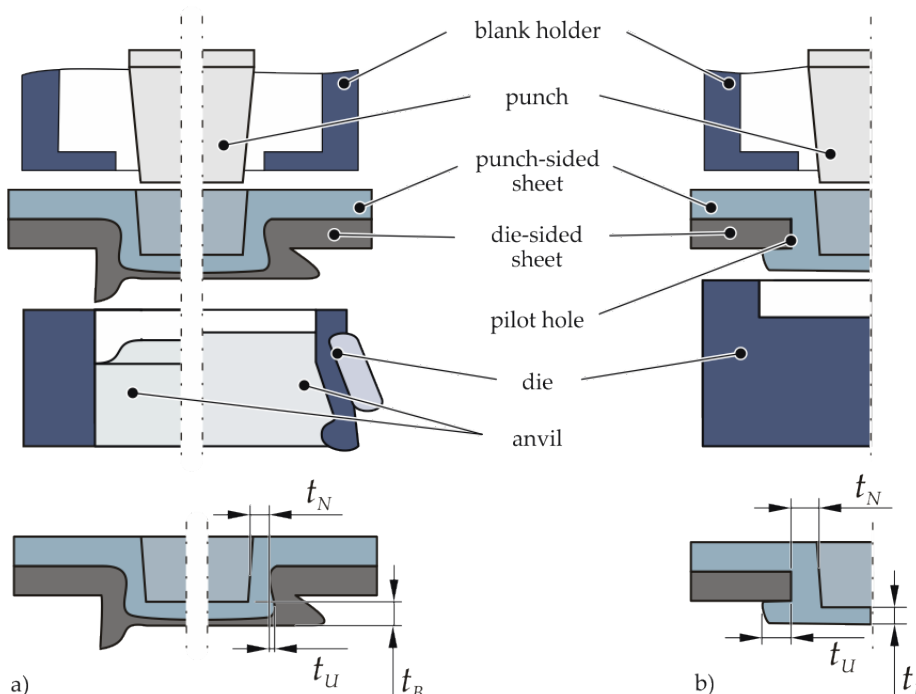
Figure 1. Clinching setup for ( a ) clinching with rigid or radial opening die and ( b ) clinching with pilot hole and relevant dimensions of clinching joints: neck thickness t N , undercut t U , and bottom thickness t B